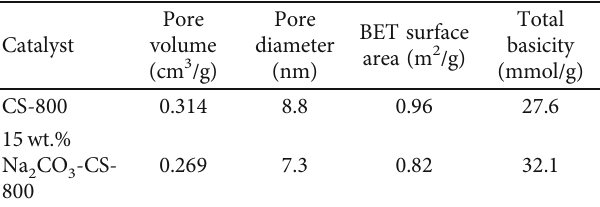
Figure 6: XRD patterns of the (a) 15 wt.% Na 800, and (c) 15wt.% Na Table 2: Surface properties and total basicity of catalysts.